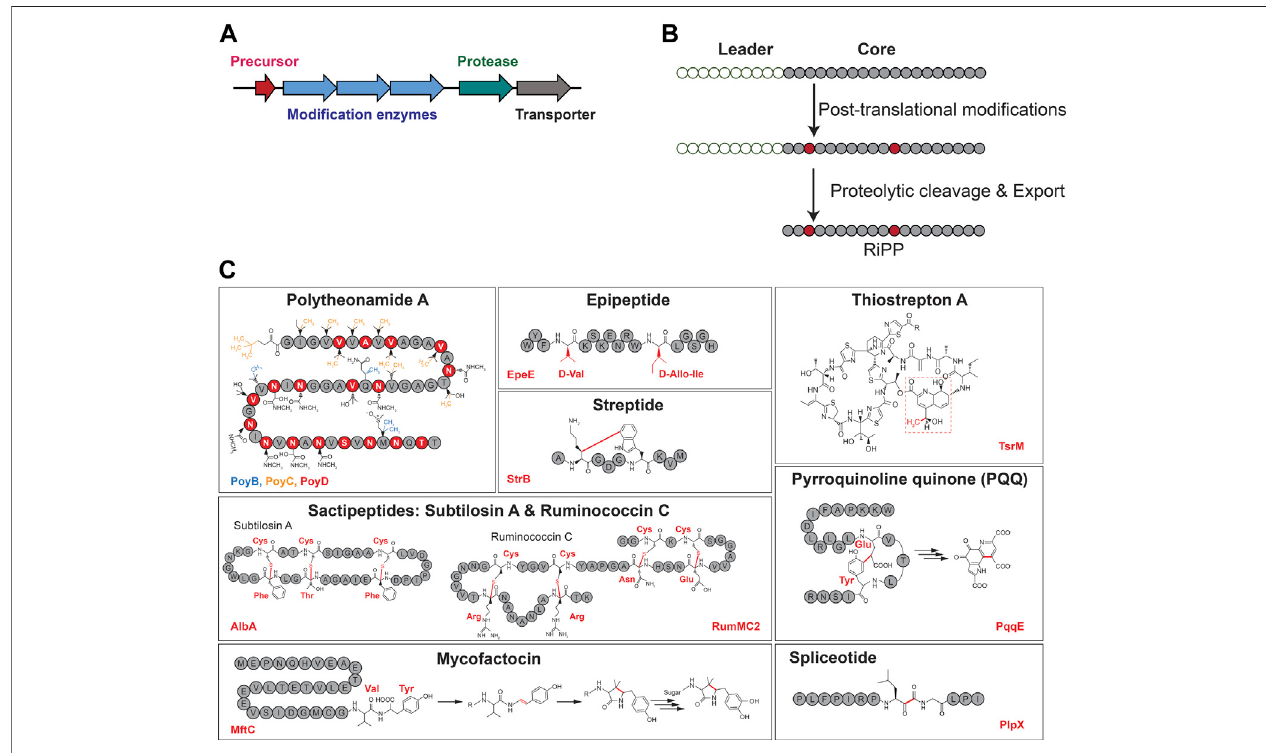
FIGURE 1 | Generic RiPP biosynthetic gene cluster (A) and biosynthetic logic (B) . (C) Representative examples of RiPPs with posttranslational modi fi cations installed by radical SAM enzymes. Radical SAM enzyme names are indicated at the bottom of each panel.